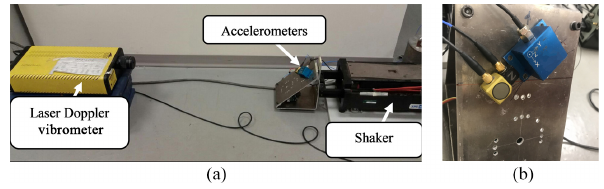
Figure 1. (a) Picture of the calibration bench. (b) Accelerometers being tested, mounted on the clamp.